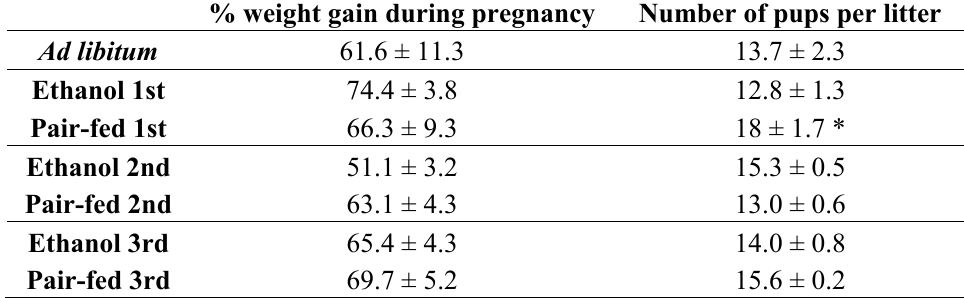
Table 1. Effect of perinatal ethanol exposure on dam weight gain during pregnancy and litter size. There were no significant differences in weight gain over pregnancy between perinatal conditions. 1st trimester pair-fed animals had significantly more pups than 1st trimester ethanol exposed animals, but all other groups had comparable litter sizes. Results are expressed as means ± standard error of the mean (SEM). Results are considered statistically significant if p < 0.05. * p < 0.05, as compared to 1st trimester ethanol exposed dams.